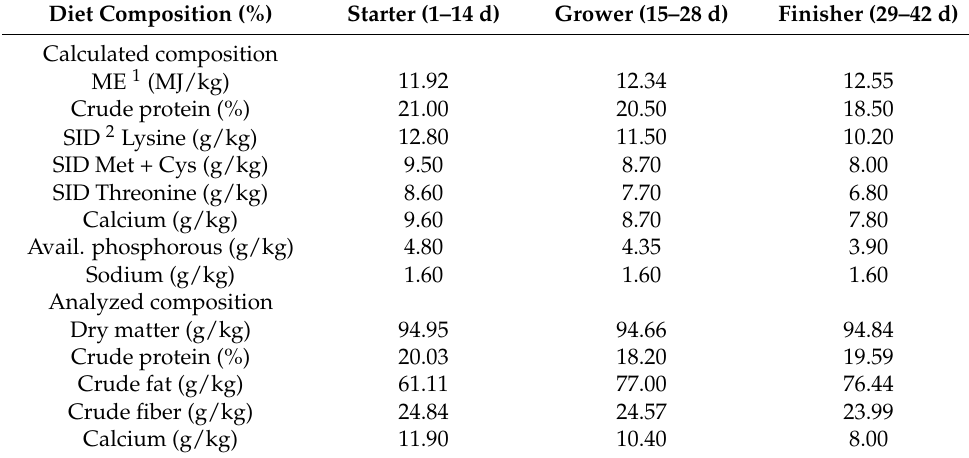
Table 2. Calculated and analyzed nutrient composition of experimental diets.